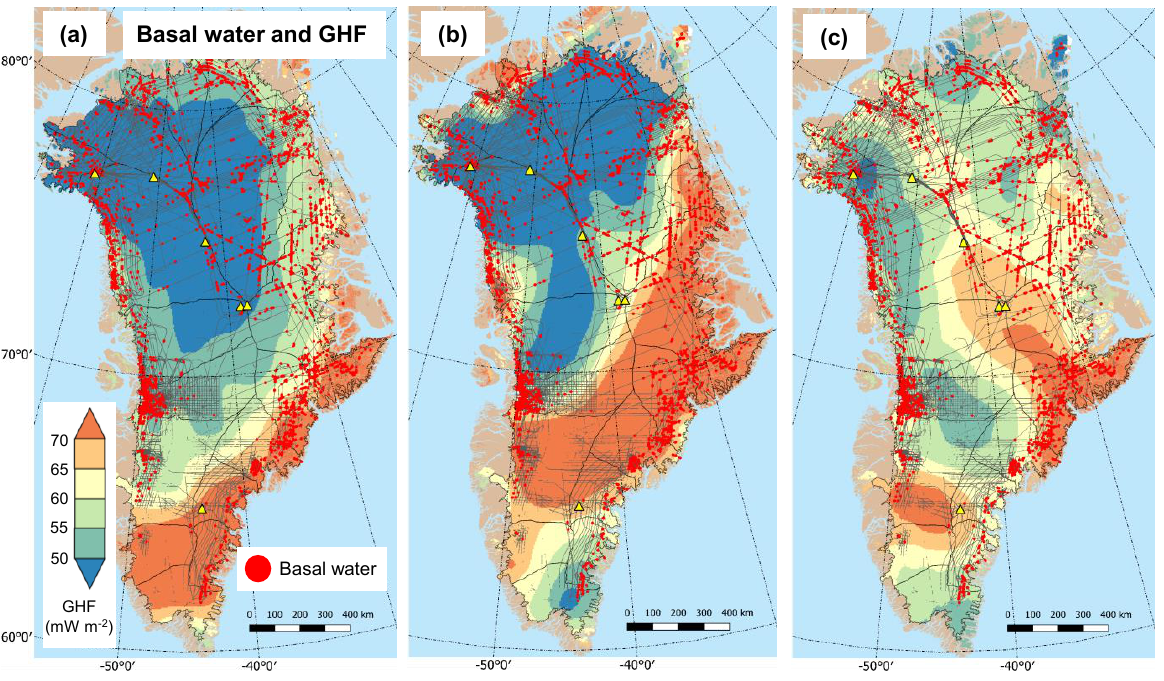
Figure 8. Comparison between basal water distribution and geothermal heat flux (GHF) models. (a) Seismic GHF model by Shapiro and Ritzwoller (2004). (b) Magnetic GHF model by Fox Maule et al. (2009) using satellite data. (c) Magnetic GHF model by Martos et al. (2018) derived from spectral methods using airborne data. The colour bar scale is the same in all panels and is truncated to emphasise the spatial variation in panel (c)